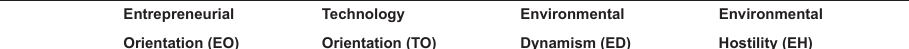
TABLE 8 Correlation Matrix for EO, TO and Environmental Hostility and